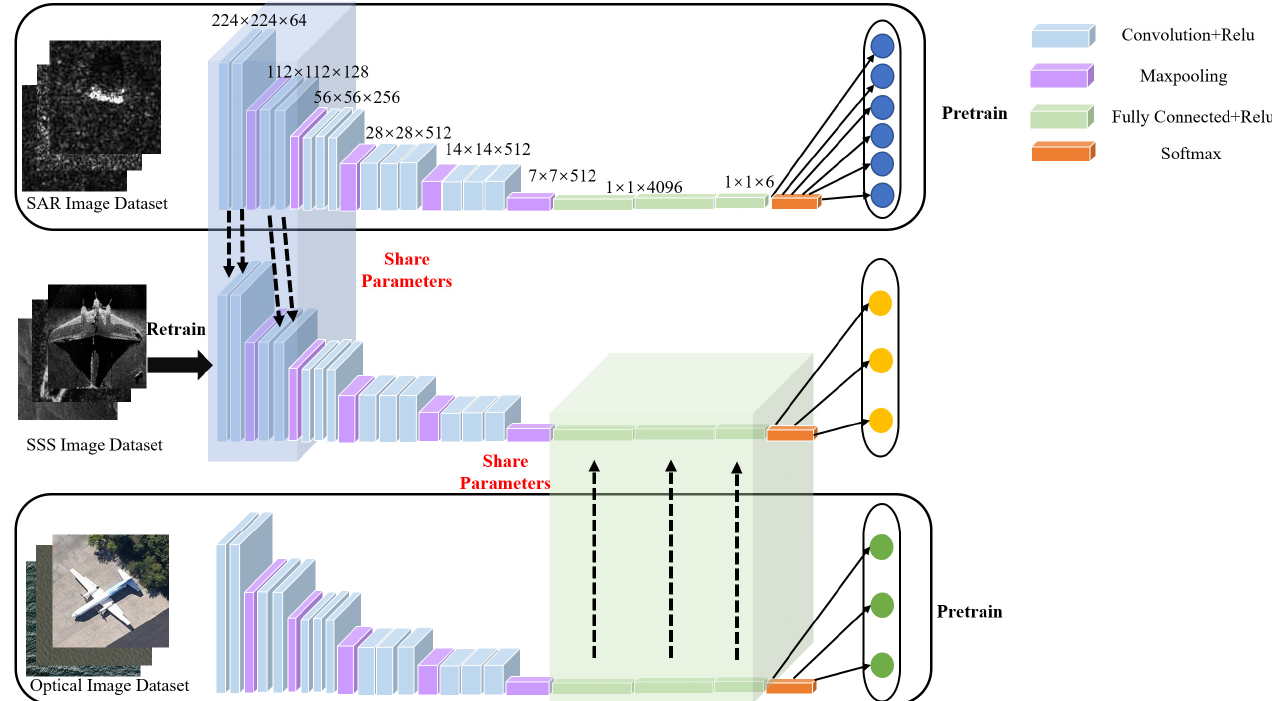
Figure 2. Architecture diagram of transfer learning from multi-domain.